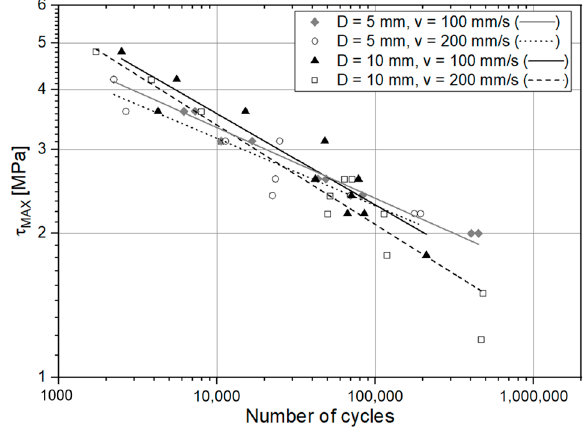
Figure 18. S-N curves for the specimens pretreated with APPT (the lines represent the power-law trend curves). Table 4. Regression coefficients of every S-N fatigue curve corresponding to a set of specimens.